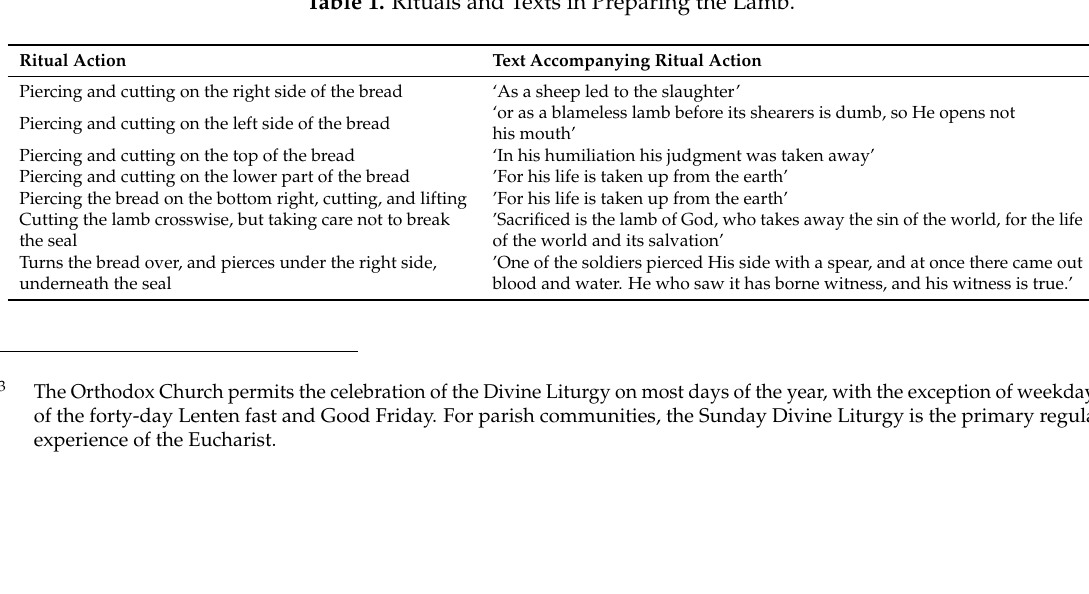
Table 1. Rituals and Texts in Preparing the